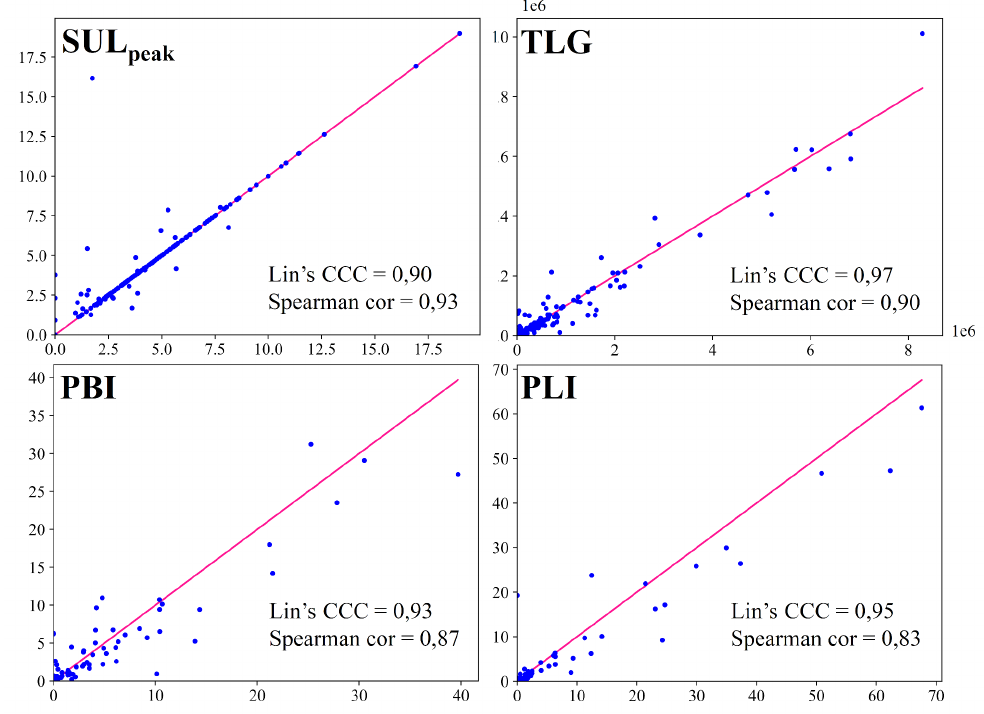
Figure 4. Graphical representation of each imaging biomarker with x axis biomarkers measured on ground truth segmentations and y axis biomarkers measured on automatic segmentations. The line represents perfect concordance. The concordance and the correlation are evaluated with the Lin’s concordance correlation coefficient (Lin’s CCC) and the Spearman’s rank correlation coefficient (Spearman cor)